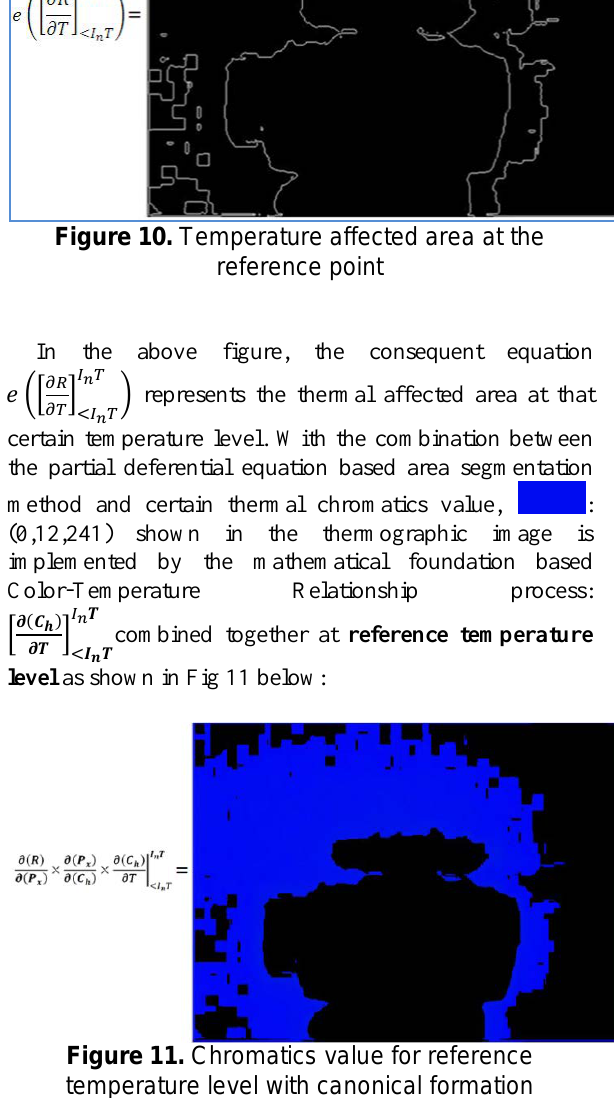
Analyzing of the region of thermographic image [37] between the temperature interval of initial (I n T) and primary tolerance point (T 1 ), boundary of the certain temperature affected area with respect to derived equation of boundary detection process is shown in Fig. 12 as